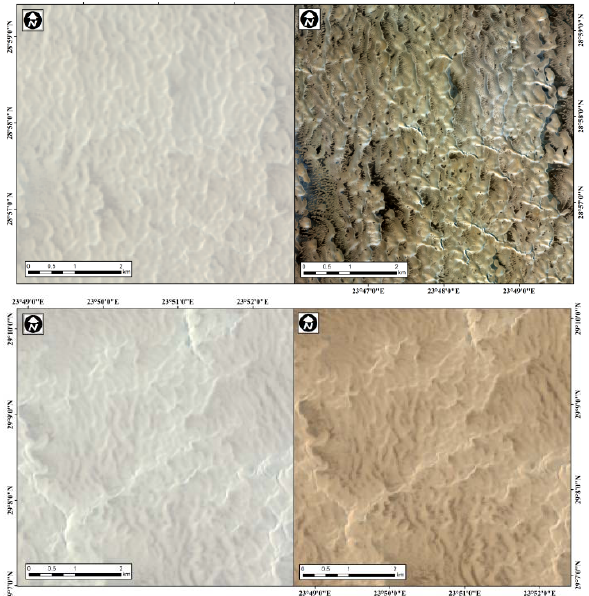
Figure 3. Common area of KOMPSAT-3, Landsat-8 and Hyperion images in Libya-4 PICS site for Appling